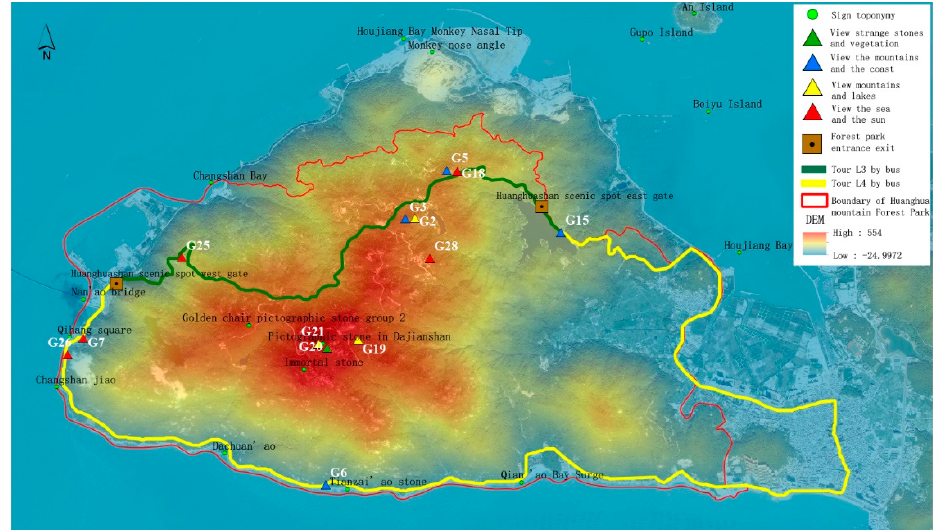
Figure 9. Bus tour routes in Huanghua Mountain scenic area.